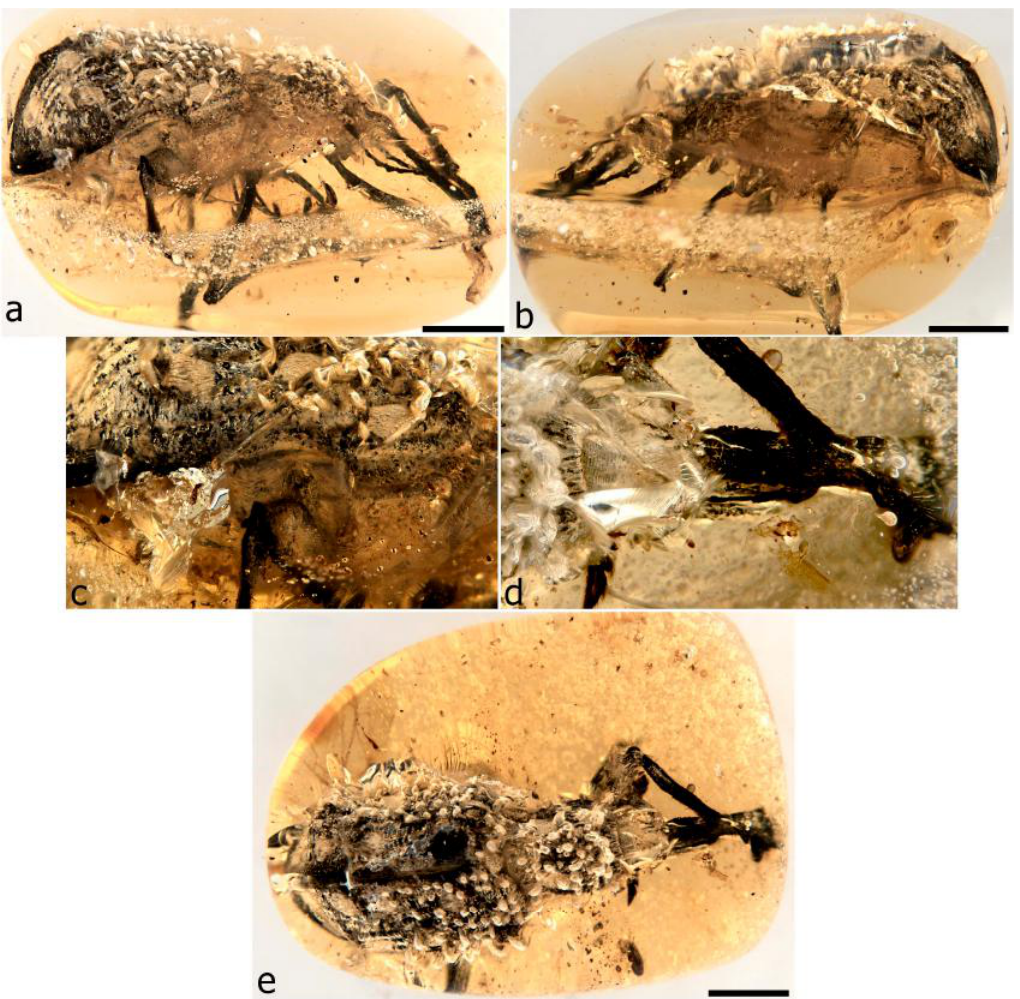
Figure 21. Nugatorhinus albomaculatus sp. n., holotype. Habitus, right lateral ( a ); habitus, left lateral ( b ); detail of elytra ( c ); head, dorsal ( d ); habitus, dorsal ( e ). Scale bars: 1.0 mm (a,b,e). Genus Calyptocis Clarke& Oberprieler, gen. n.